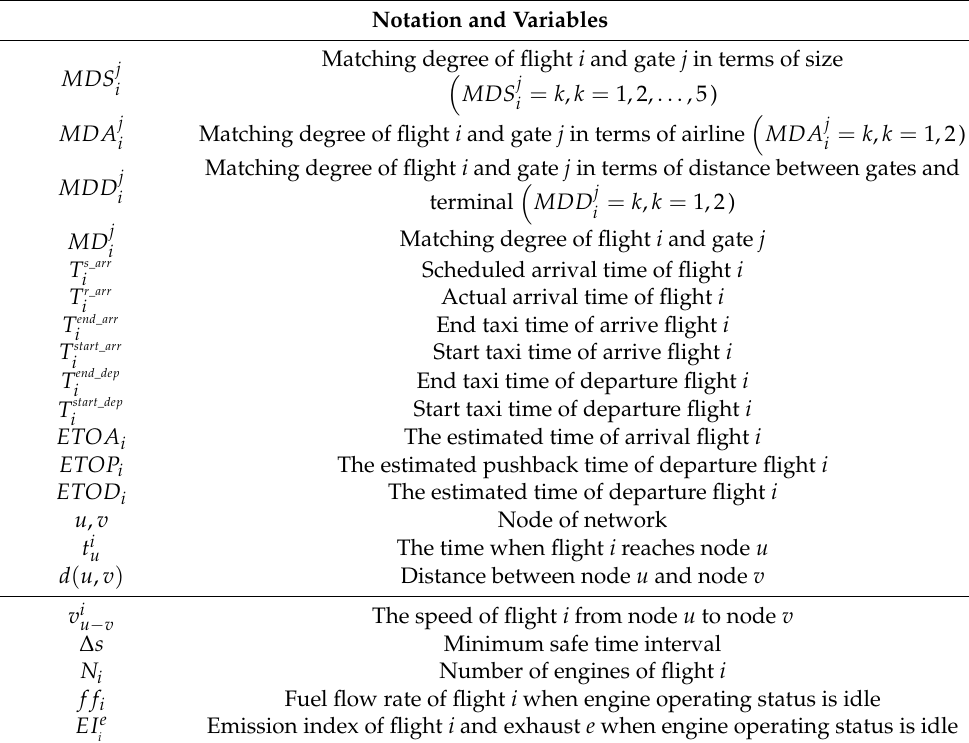
Notation and Variables Matching degree of flight i and gate j in terms of size